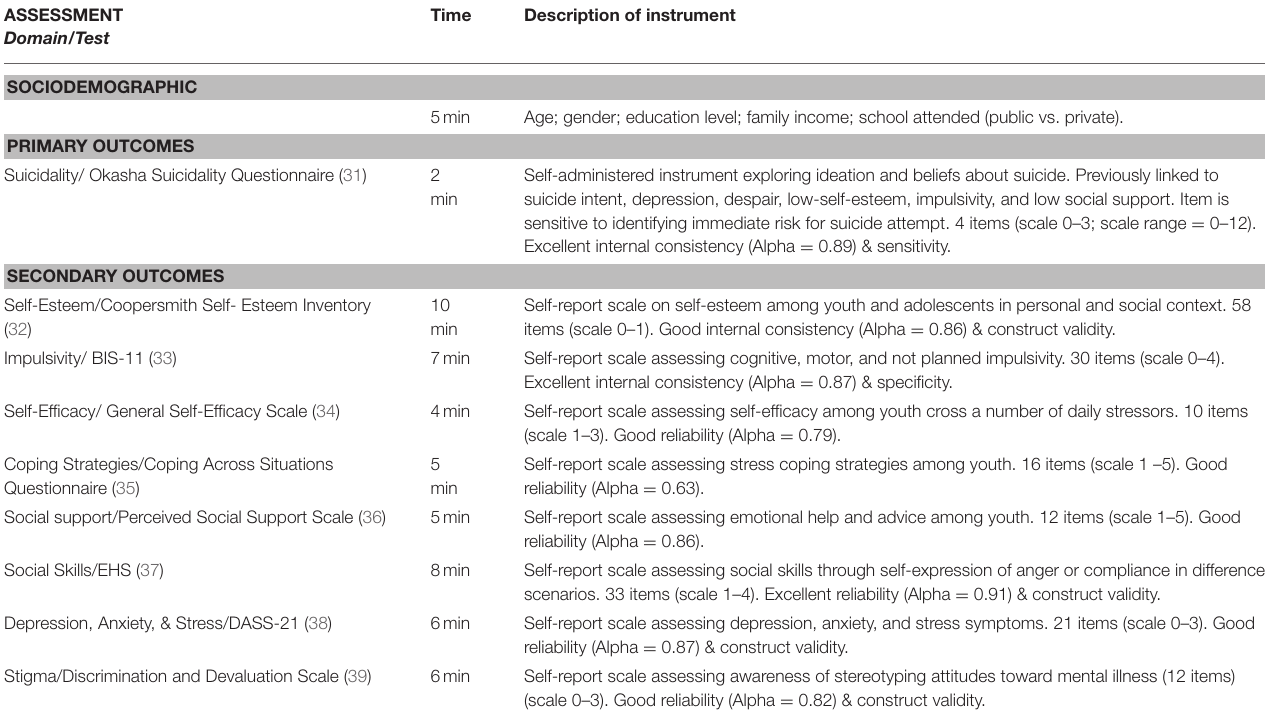
TABLE 2 | Outcome and Measures. ASSESSMENT